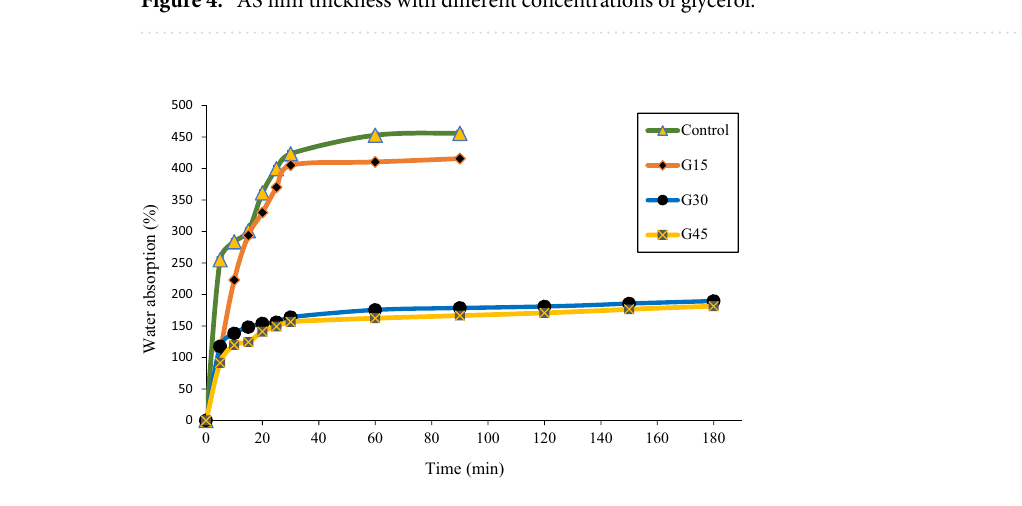
Figure 5. Water absorption of the control and G-plasticized AS films as a function of